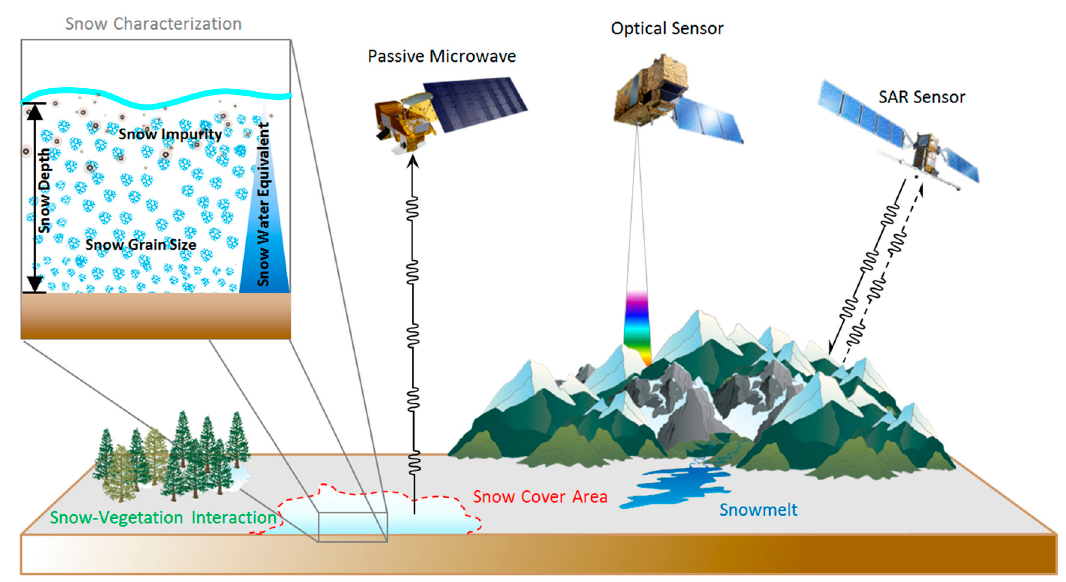
Figure 5. Thematic diagram of snow monitoring by spaceborne Earth observation.